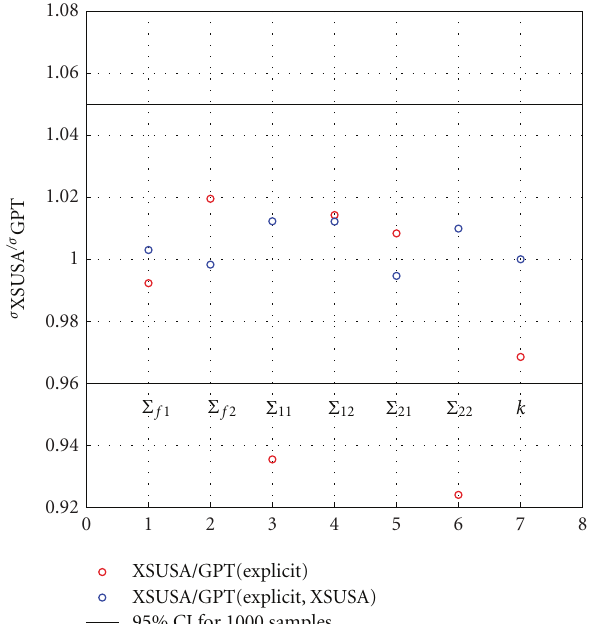
Figure 3: The ratio of the stochastic to generalized perturbation theory standard deviations of few-group cross sections. The independent axis represents various cross section indices.